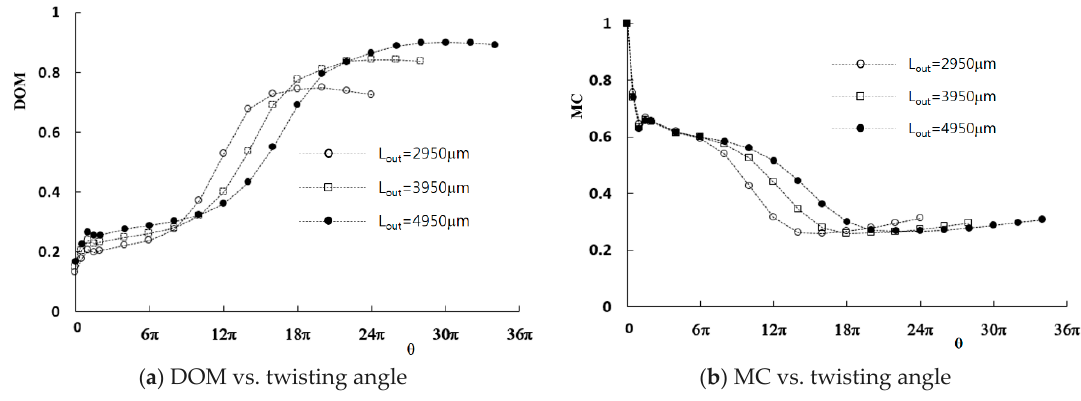
Figure 10. Effects of length of the outlet branch on mixing. Figure 10. E ff ects of length of the outlet branch on